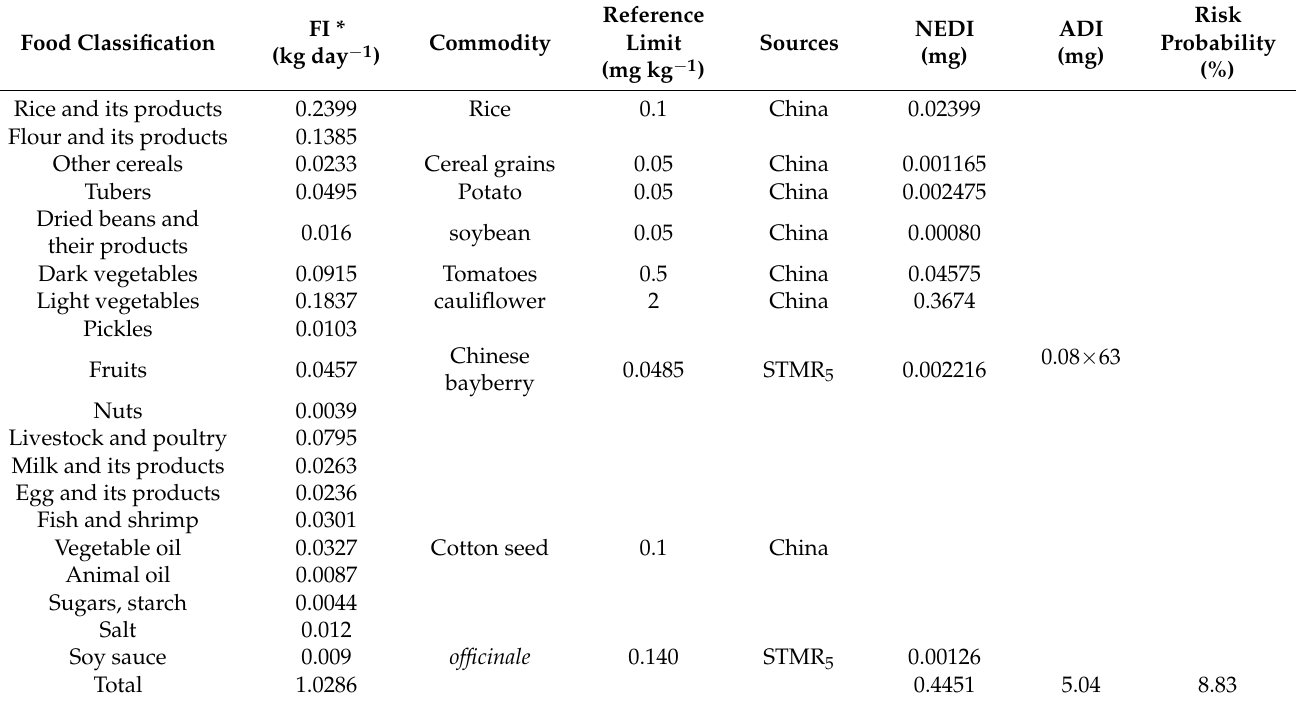
Table 4. The Chinese dietary model and risk probability of metalaxyl in Chinese bayberry and D. officinale and the corresponding MRLs registered by various